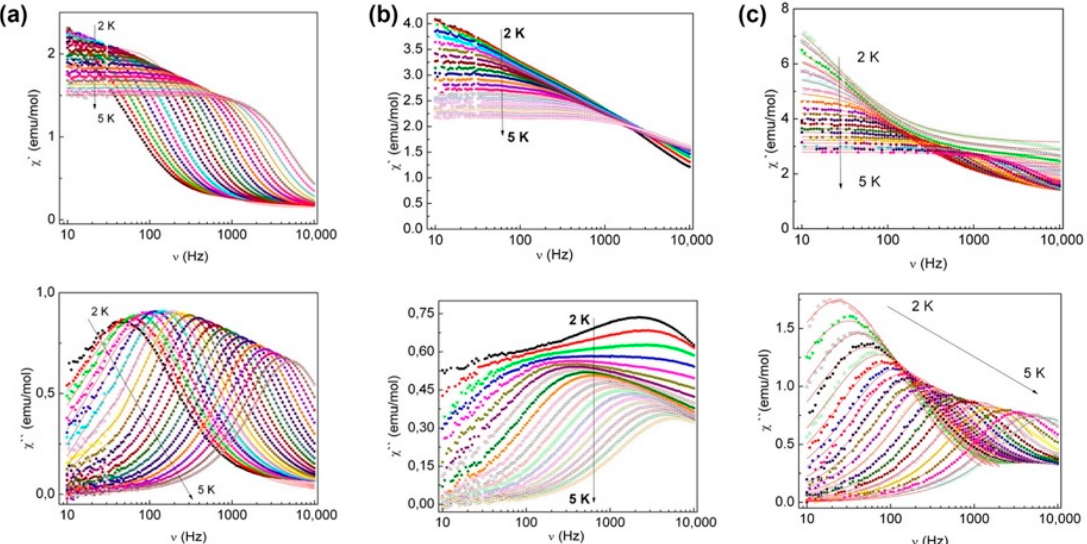
Figure 7. The frequency-dependence of the χ′ ( ν ) ( top ) and χ′′ ( ν ) ( bottom ) for 4 ( a ) under H DC = 1500 Oe, 3 ( b ) under H DC = 800 Oe, and 6 ( c ) under H DC = 300 Oe. The figures are reproduced from Reference [40] with permission from MDPI.